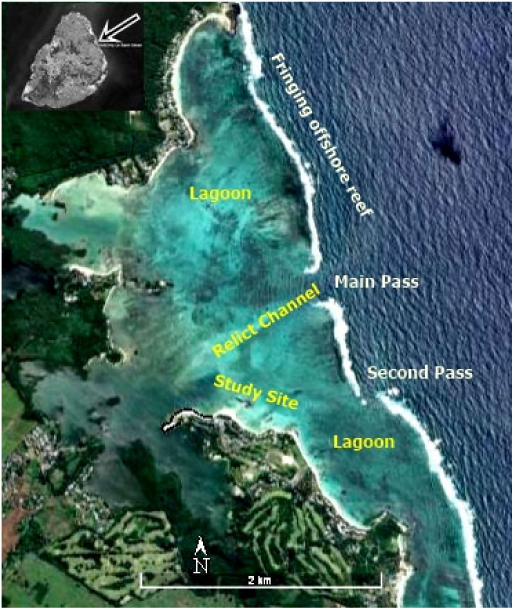
Figure 1. Study site and environs. The arrow on the inset map of Mauritius shows the site